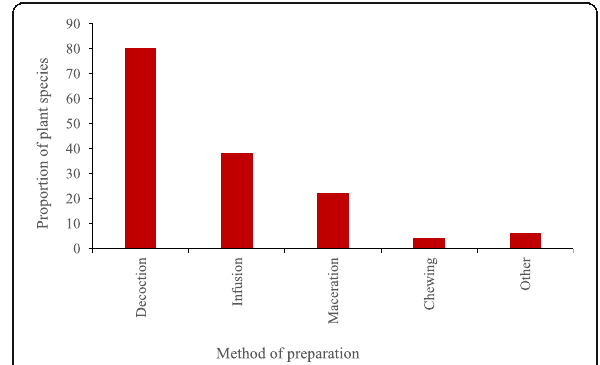
Fig. 1 The figure illustrates the percentage of medicinal plant species used for making herbal remedies using different methods according to information obtained from respondents. The